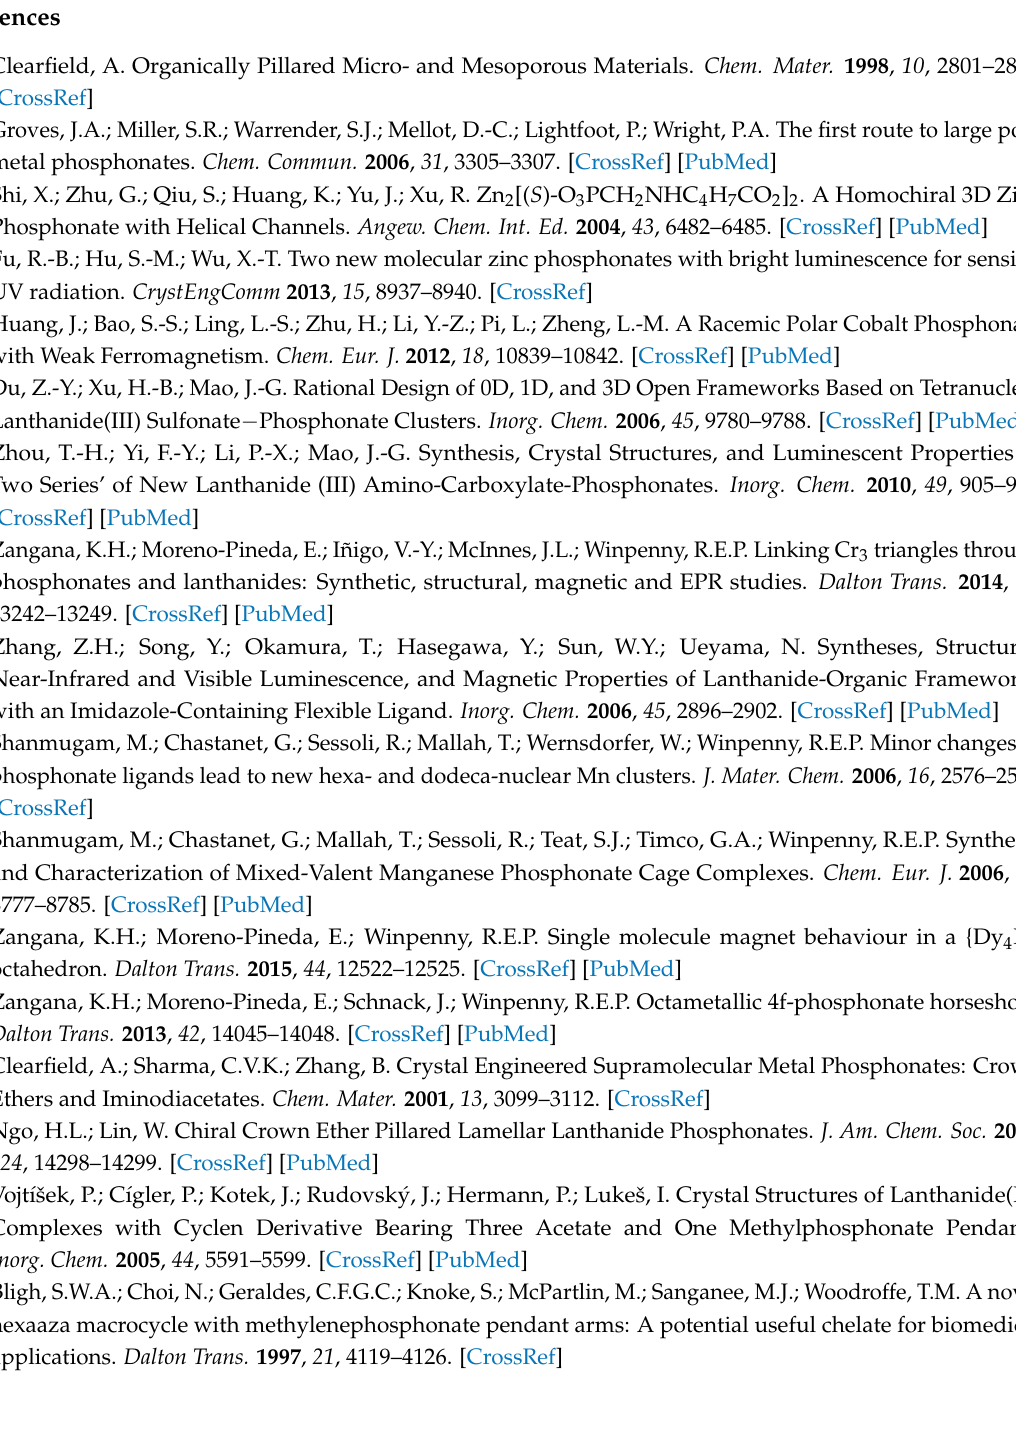
Figure S1: Crystal structure of {Ln 10 P 5 } cluster, Figure S2: Metal and phosphonate core in {Gd 10 P 5 }, Figure S3: Polyhedral view of {Ln 10 P 5 } core, Figure S4: Variation of χ M T vs. T for 2 at 1 kOe from 2–300 K, Figure S5: M β vs. H for 2 at different temperatures (2–9 K) in the field range comprising 0 to 7 T, Figure S6: IR spectra for compound 1 (blue trace) and compound 2 (green trace), Table S1: CShM values for the Gd metal ion centers of 1 , Table S2. Selected bond distances and angles of compounds 1 and 2